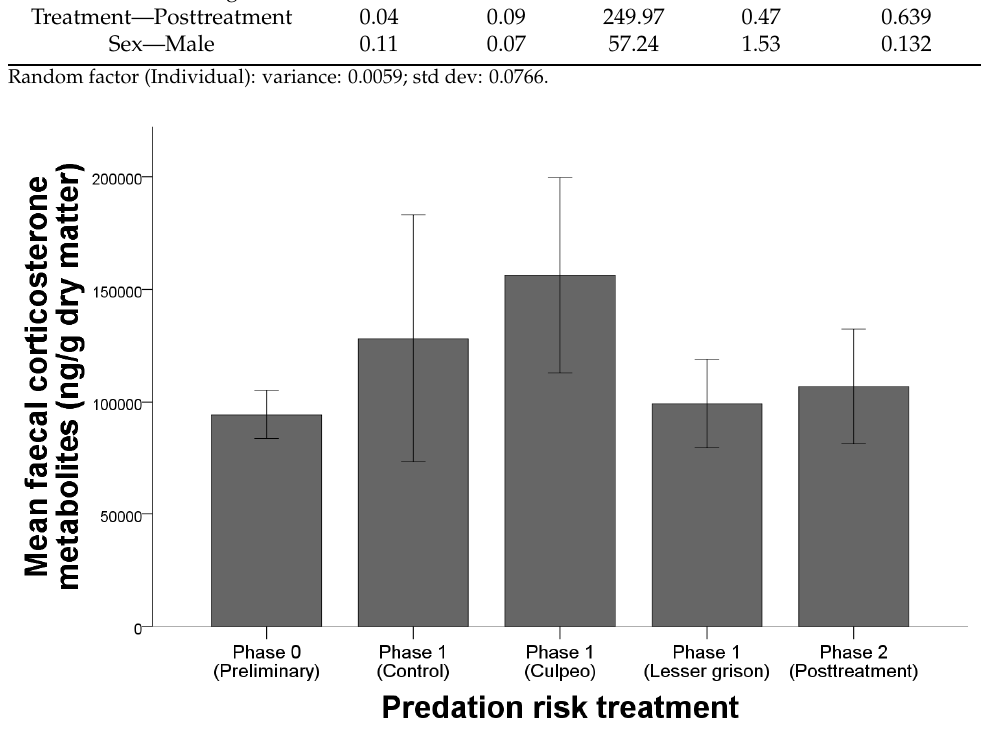
Figure 2. Mean faecal corticosterone metabolite levels of O. longicaudatus depending on the preda- tion risk treatment (Phase 0 — Preliminary/Phase 1 — Control/Phase 1 — Culpeo/Phase 1 — Lesser gri- son/Phase 2 — Post treatment).